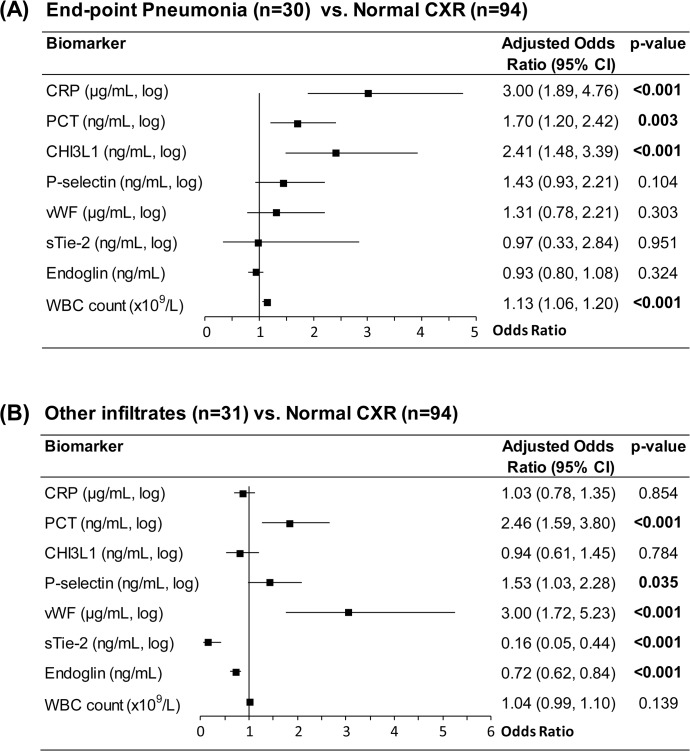
Adjusted associations for biomarkers of host response in children with abnormal versus normal chest x-ray (CXR).Odds ratios were calculated comparing groups using multivariate logistic regression, adjusting for statistically significant demographic and clinical differences between groups. All markers except endoglin and WBC were log transformed since distributions were non-normal. Forest plots show odds ratio point estimates (black squares) and 95% confidence intervals (lines). (A) Odds ratios for end-point pneumonia versus normal CXR, adjusted for age and sex. (B) Odds ratios for other infiltrates versus normal CXR, adjusted for temperature. CHI3L1, Chitinase 3-like-1; CRP, C-reactive protein; CXR, chest x-ray; PCT, procalcitonin; sTie-2, soluble Tie-2; vWF, von Willebrand Factor; WBC, white blood cell.